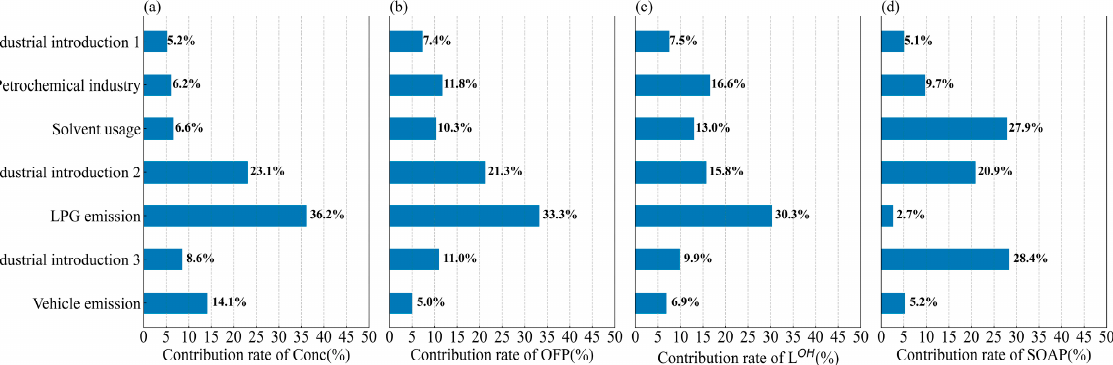
Figure 8. The source contributions to the concentrations ( a ) of OFP ( b ), L OH ( c ) and SOAP ( d ) in the autumn.